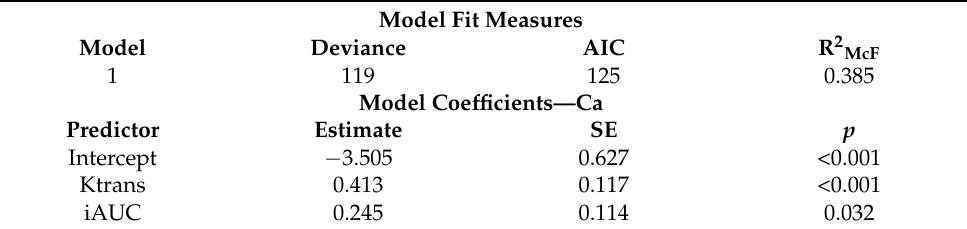
Table 4. Presentation of parameter estimate in